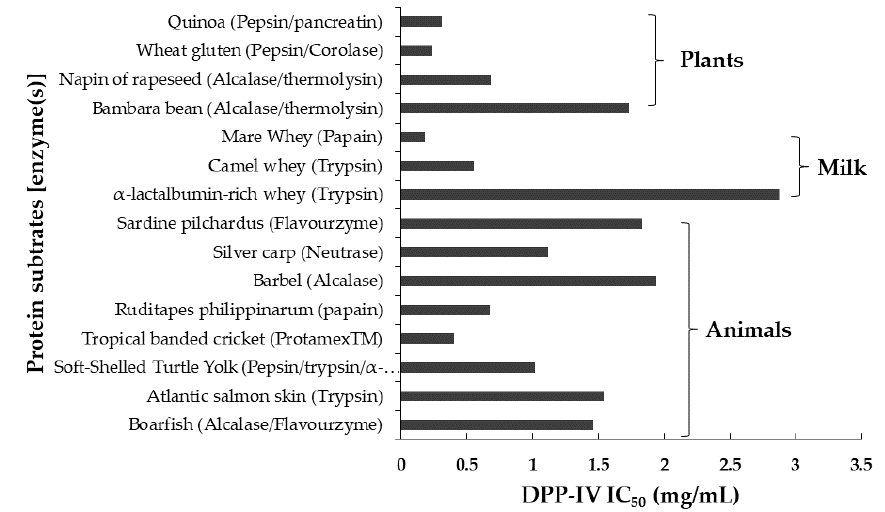
Figure 4. Food protein-derived hydrolysates displaying in vitro dipeptidyl peptidase (DPP-IV) half maximal inhibitory concentration (IC 50 ) values (2016–2020).